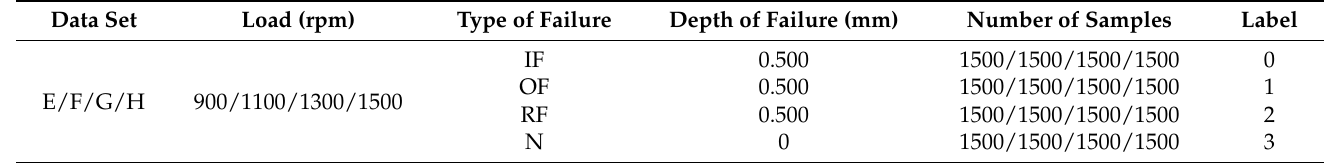
Figure 12. The private data set experiment platform. Table 4. The test 2 data set detailed partition table.